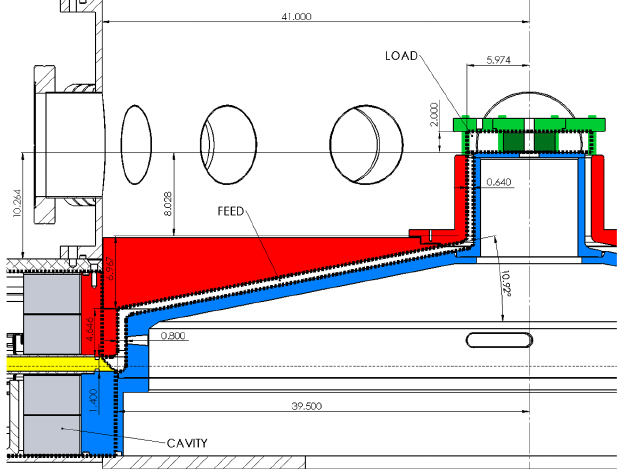
FIG. 4. Cross-section drawing of the vacuum power feed. All dimensions are in centimeters. The anode electrode is colored in red, the cathode electrode is colored in blue, the cavity insulating plate is colored in yellow, and a short-circuit example load is colored in green. The dashed lines delimit the cavity on the left, the vacuum feed in the middle, and the load regions near the